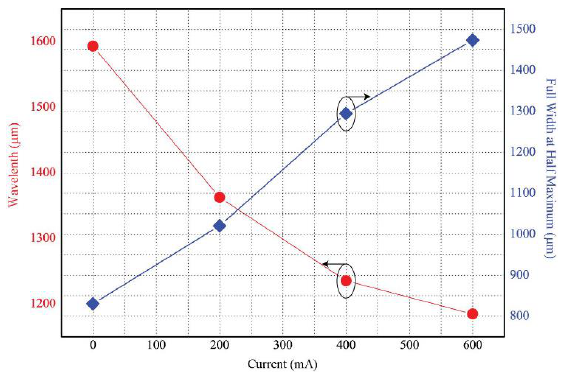
Figure 10. Peak transmittance wavelength shift and full width half maximum (FWHM) change as a function of applied current.